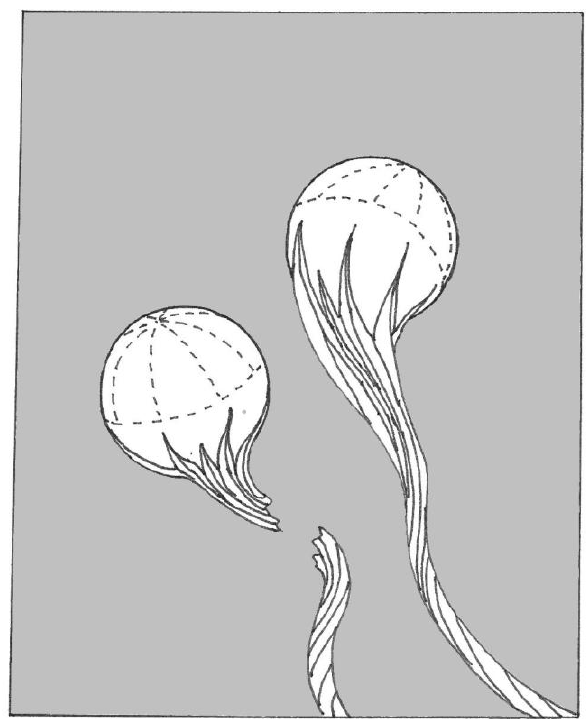
Figure 2. Schematic illustration of air bubbles rising in a liquid metal, their oxide sloughing off to create a bubble trail, a kind of long tubular